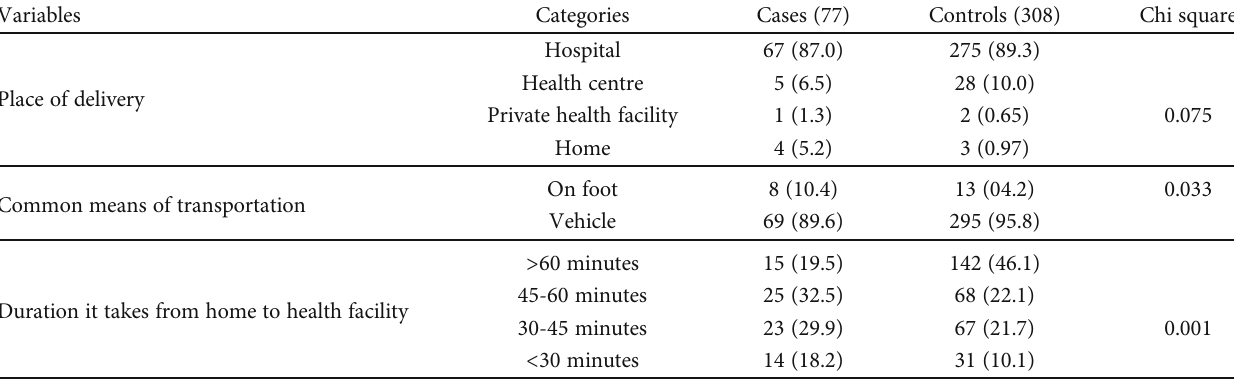
Table 4: Health facility and related factor of neonatal sepsis among neonates at SCGH and WSUTRH, Wolaita Sodo town, 2019.